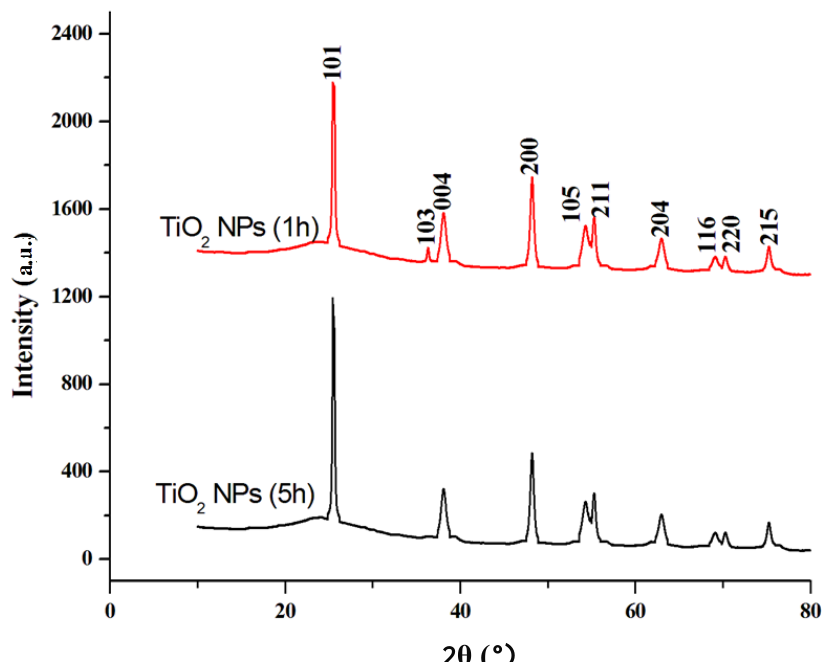
Figure 3. X-ray diffraction (XRD) of TiO 2 nanoparticles (NPs).